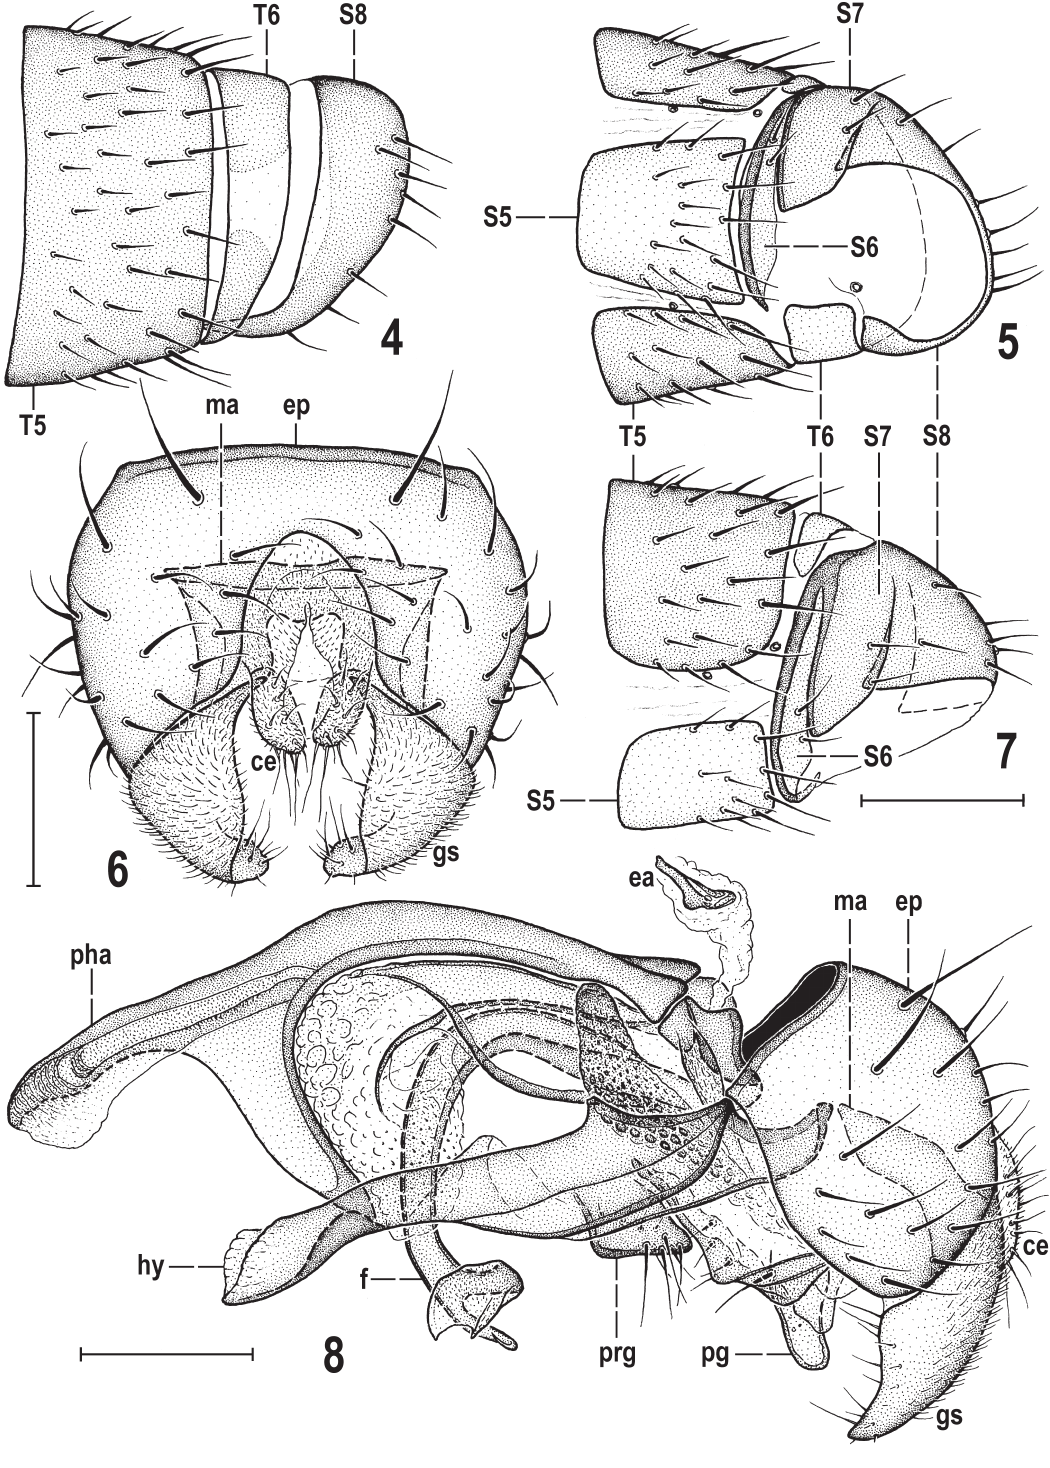
Figs 4–8. Mumetopia interfeles Roháček sp. nov., male paratypes (SMOC MIT004–MIT007). 4 . Postabdomen with fifth abdominal segment, dorsal view. 5 . Same, ventral view. 6 . External genitalia, caudal view. 7 . Postabdomen with fifth abdominal segment, lateral view. 8. Genitalia, lateral view. Scale bars: 4–5, 7 = 0.2 mm; 6, 8 = 0.1 mm. For abbreviations see Material and